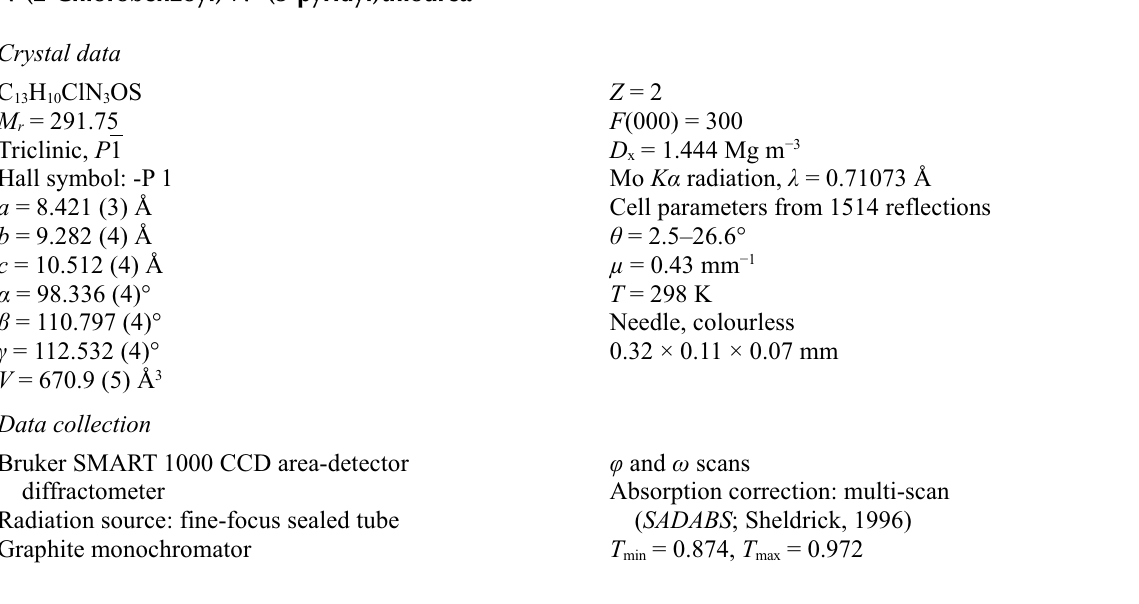
The supramolecular chain structure of the title compound constructed by intermolecular N—H···N hydrogen bonding interactions (dotted